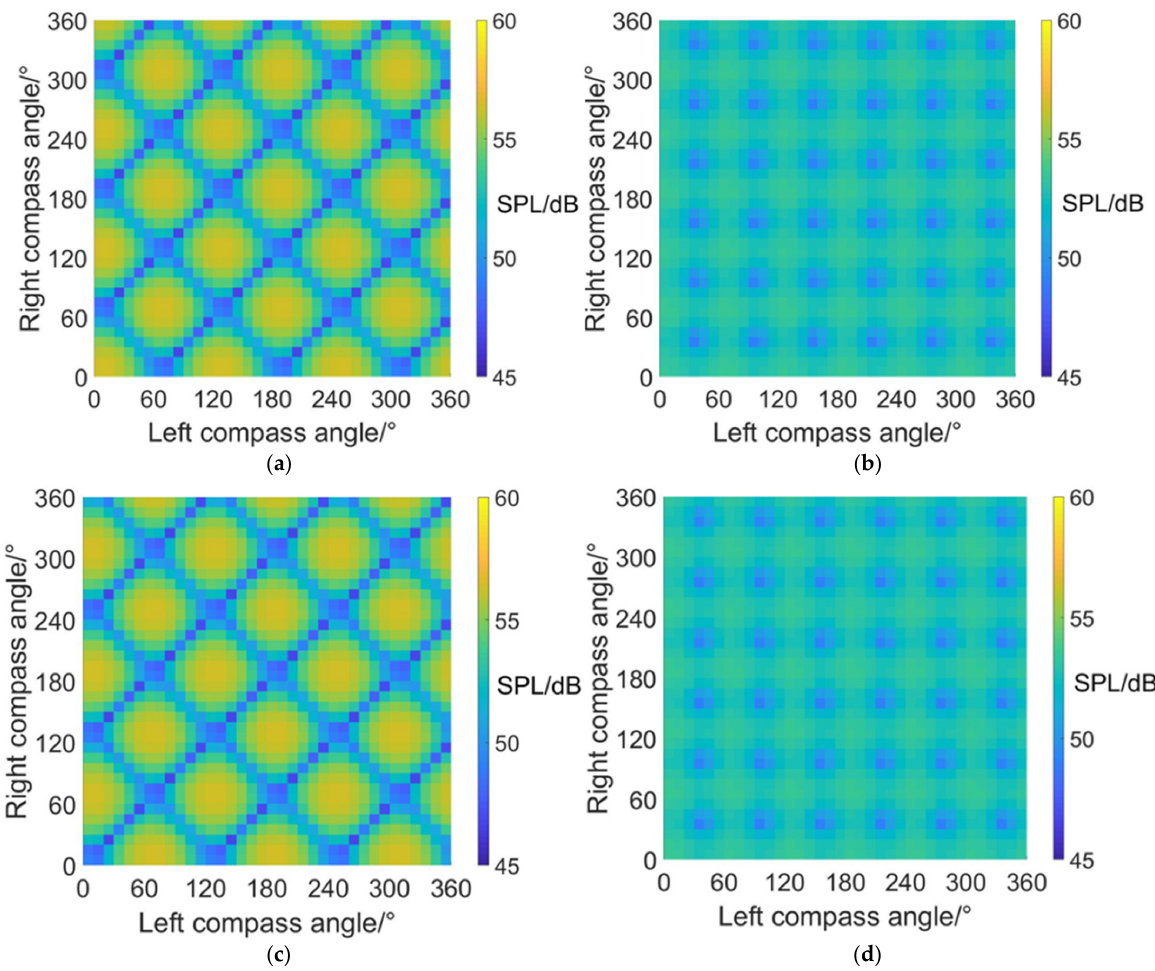
difference = 30° or 90°. However, the positions are different compared with Figure 10. difference = 30 ◦ or 90 ◦ . However, the positions are different compared with Figure 10.